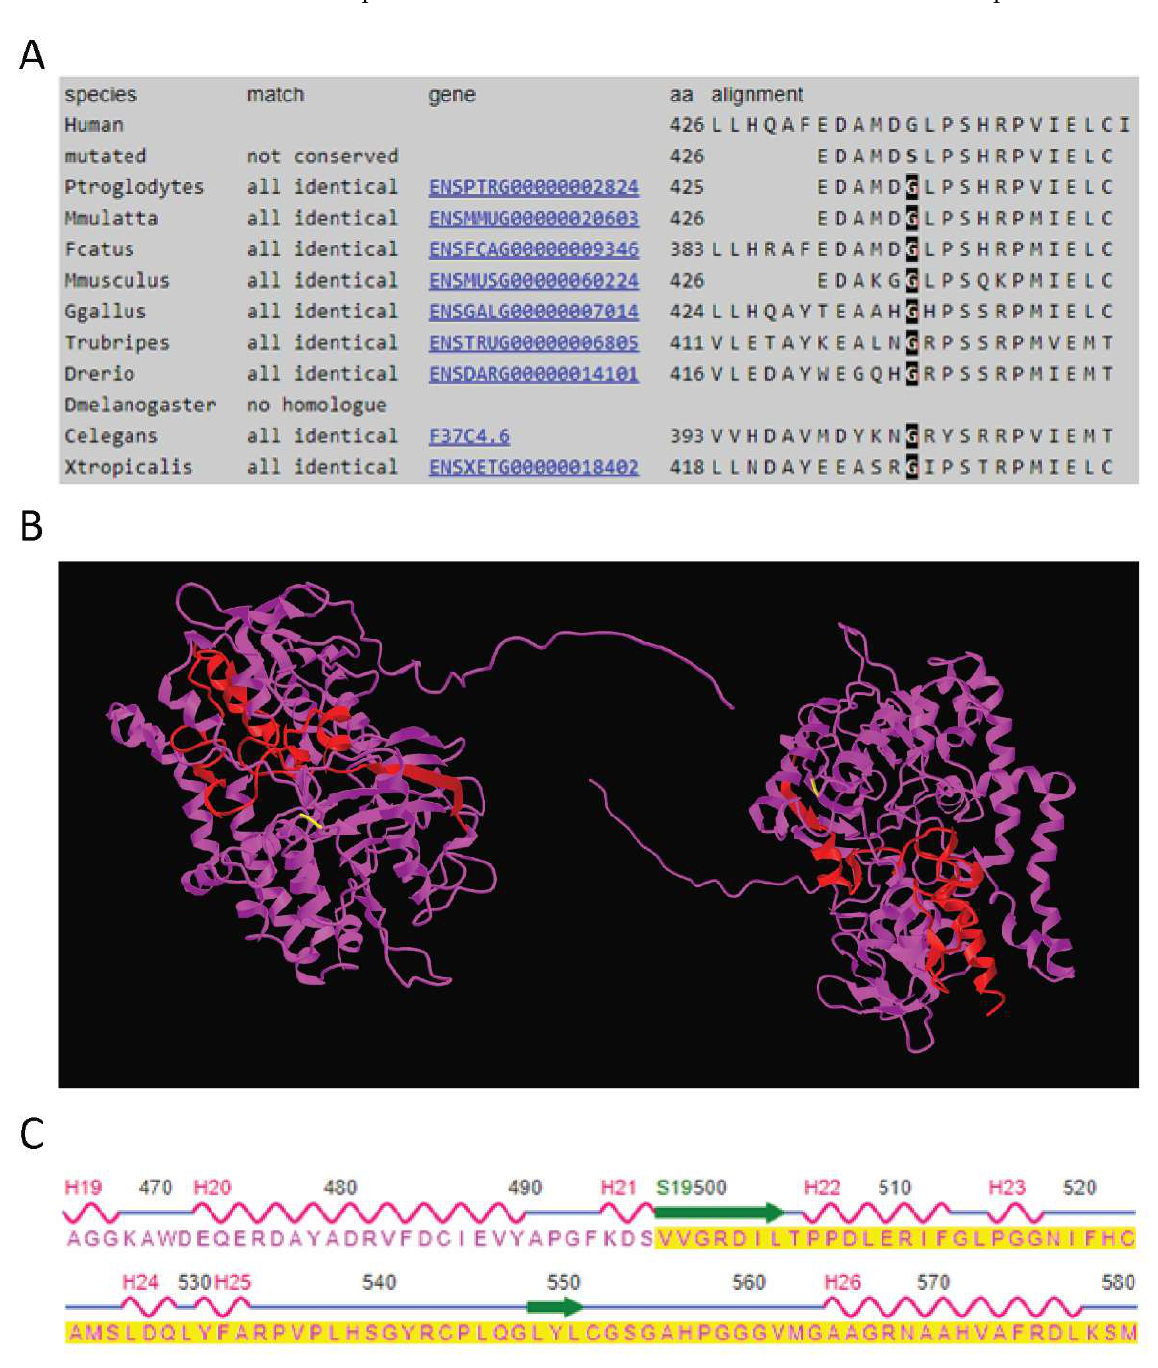
Figure 3. Evolutionary sequence conservation and 3D structure of PYROXD2 . ( A ) The multiple sequence alignment of PYROXD2 reveals the affected p.Gly426 residue is highly conserved. ( B ) The predicted 3D structure of wild-type PYROXD2 (AF-Q8N2H3-F1, AlphaFold, modelled in icn3d) highlighting the patient variant p.(Gly426Ser) is highlighted in yellow, and the wild-type residues affected by the frameshift variant p.(Val498Cysfs*79) are highlighted in red. ( C ) Structural regions (from icn3d) indicate that the frameshift variant starting at p.Val498 (region highlighted in yellow) affects a beta-fold region (amino acids 498–504) and two major alpha-helical regions (amino acids 506–513 and 565–578) of the PYROXD2 protein.